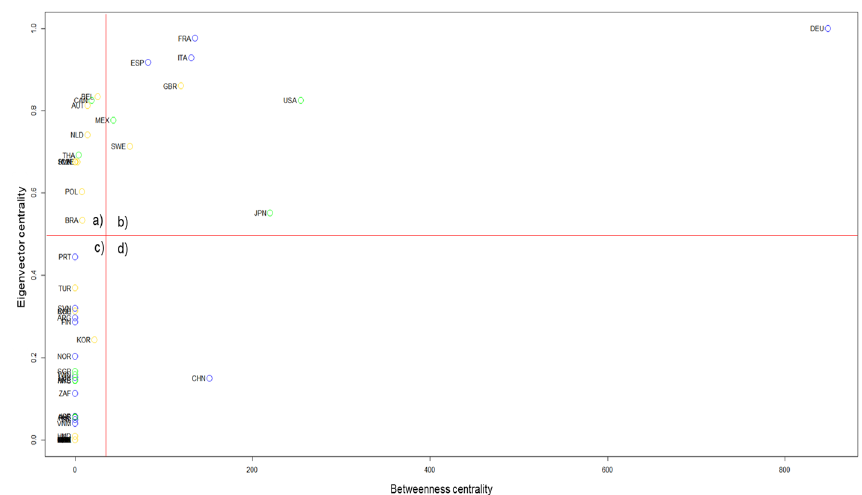
Fig. 3 Centrality measures. The graph shows the relation of the betweenness centrality and the eigenvector centrality by country. a Reveals high low betweenness centrality and high eigenvector centrality. b Provides both high betweenness centrality and high eigenvector centrality. c Shows both low betweenness centrality and low eigenvector centrality. d Inform high betweenness centrality but low eigenvector centrality. The division of betweenness centrality relies on the mean for all countries, while eigenvector centrality takes 0.5 as the division point (Source: Own elaboration with EORA